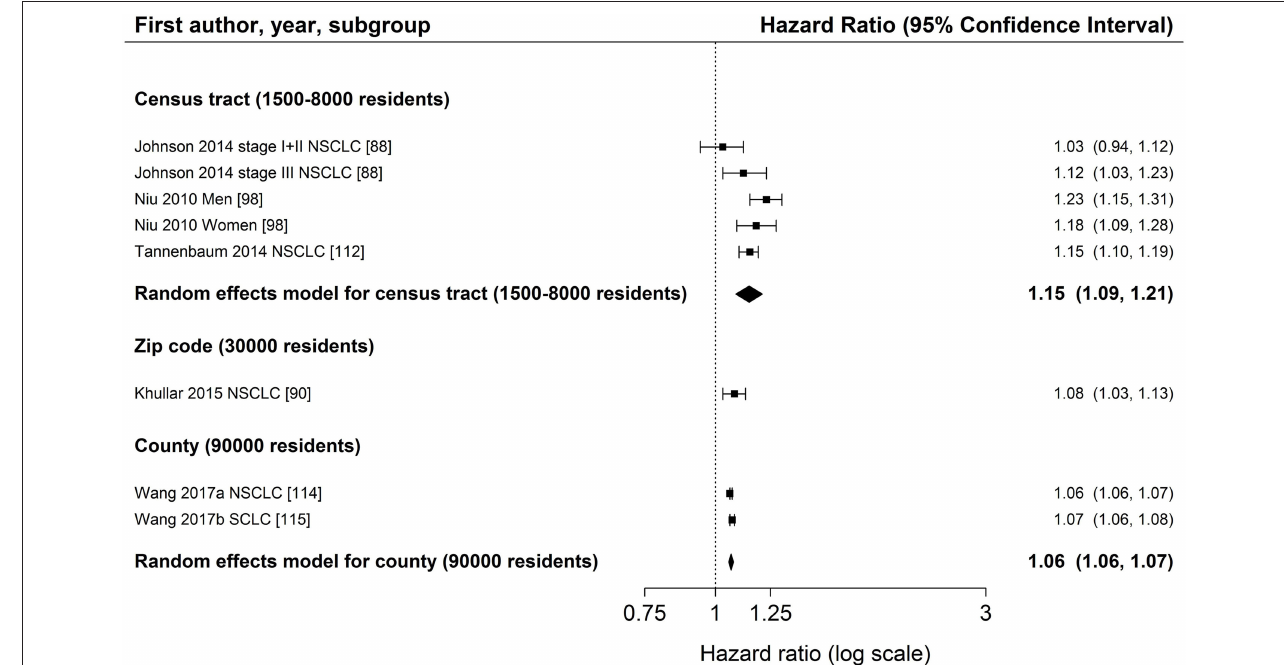
FIGURE 6 | Meta-analysis of studies from the United States on the association of area-based income (reference: high income) and survival after lung cancer. Order: small to large area level. NSCLC, non-small cell lung cancer; SCLC, small cell lung